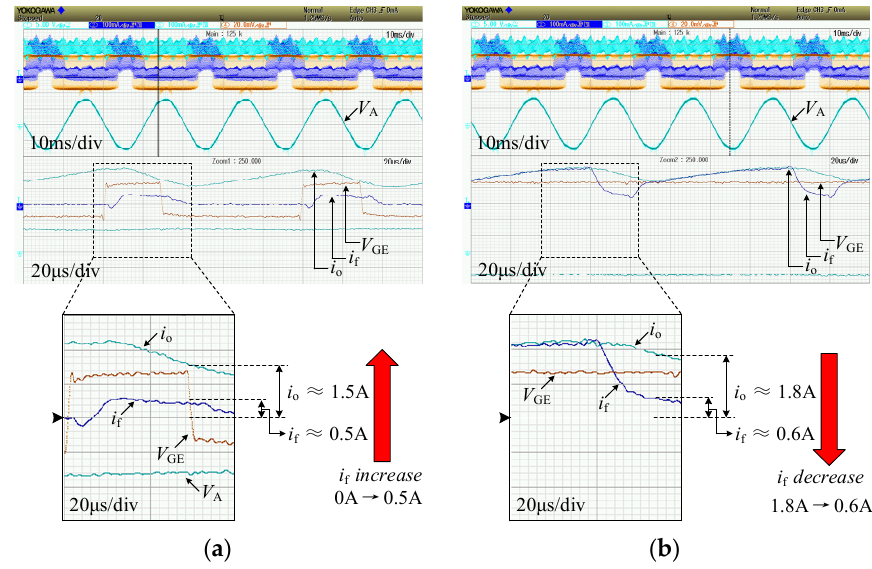
Figure 15. Flowing current of S 21 : input phase voltage V A (50 V/div), output current i o (1 A/div), flowing current i f (1 A/div), and measured drive signals V GE (10 V/div). ( a ) Detailed flowing current in Section 1. ( b ) Detailed flowing current in Section 4.